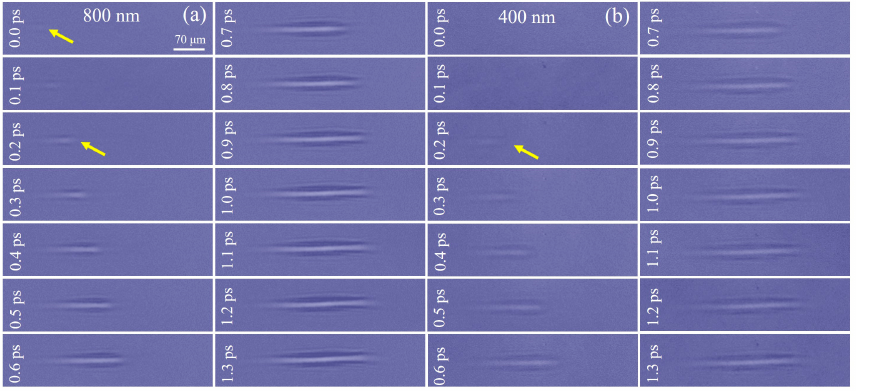
Figure 2. Time evolution of a femtosecond pulse laser-induced air plasma filament under ( a ) an 800-nm probe pulse and ( b ) a 400-nm probe pulse. The yellow arrow indicates the initial formation of air plasma fi lament.